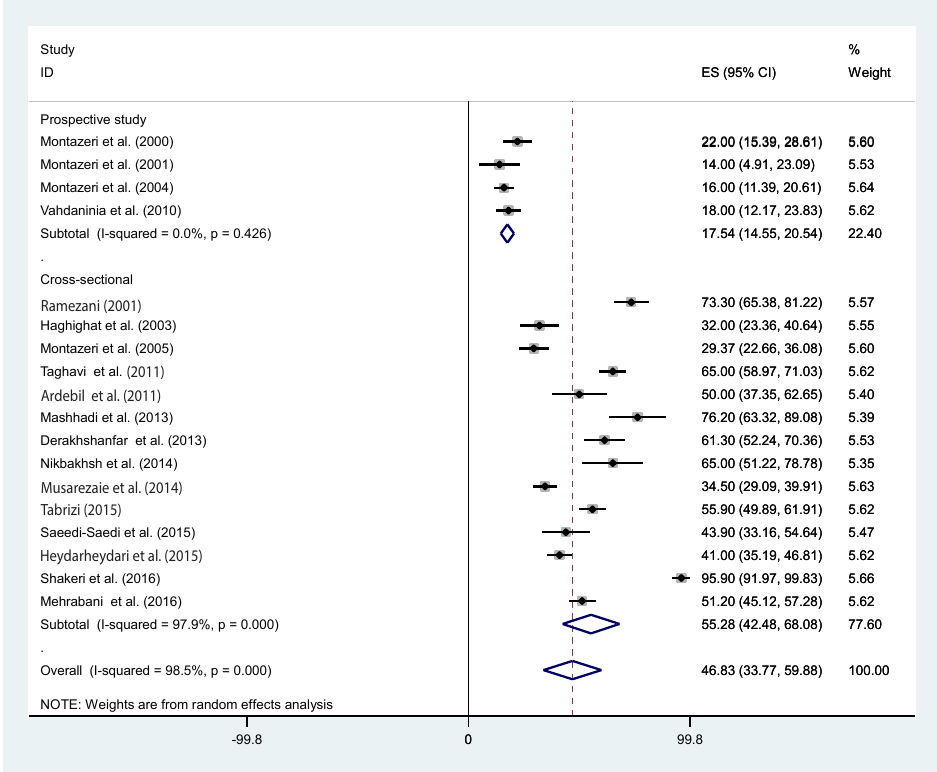
Figure 6. F orest plot of all studies based on study design.